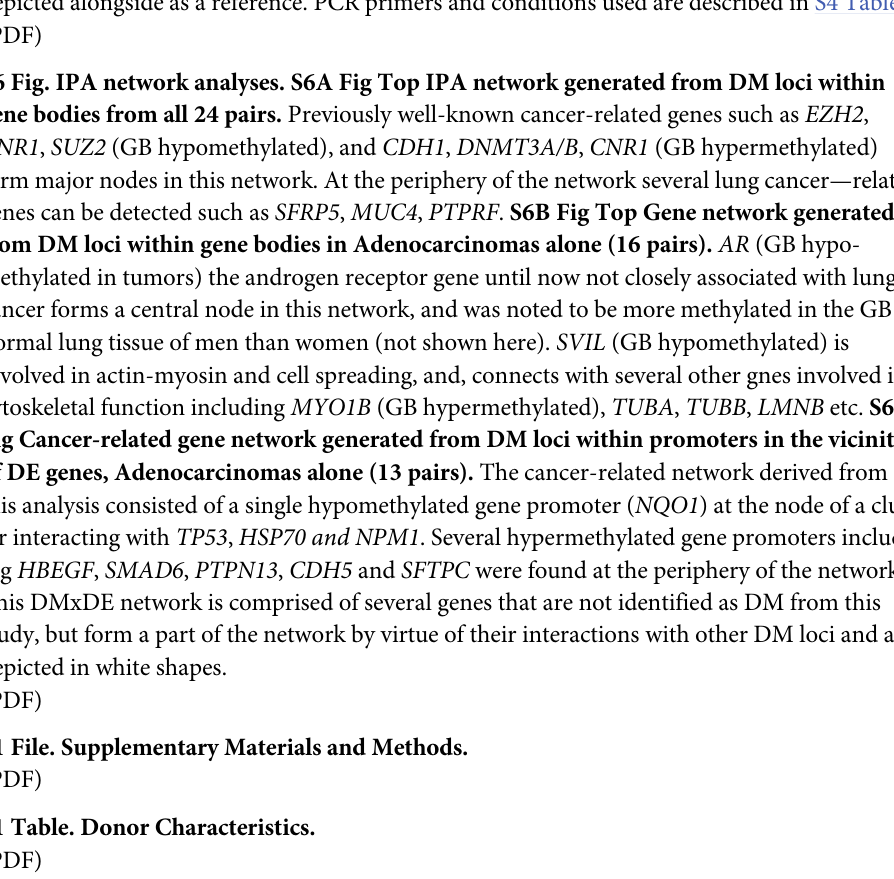
S5 Fig. Validation of gene-expression changes by qRT-PCR. Verification was performed in top representative genes that show canonical promoter patterns; PR:hypermethylation and GE downregulation and PR:hypomethylation & GE upregulation. Among DE genes associated with promoter DM loci (S3 Table), these eight genes were selected for qRT-PCR quantitation of gene-expression. All fold changes are depicted for T relative to matched NT; gene-expression values were normalized to GAPDH expression levels. Microarray fold-change values are depicted alongside as a reference. PCR primers and conditions used are described in S4 Table. S6 Fig. IPA network analyses. S6A Fig Top IPA network generated from DM loci within gene bodies from all 24 pairs. Previously well-known cancer-related genes such as EZH2 , CNR1 , SUZ2 (GB hypomethylated), and CDH1 , DNMT3A/B , CNR1 (GB hypermethylated) form major nodes in this network. At the periphery of the network several lung cancer — related genes can be detected such as SFRP5 , MUC4 , PTPRF . S6B Fig Top Gene network generated from DM loci within gene bodies in Adenocarcinomas alone (16 pairs). AR (GB hypo- methylated in tumors) the androgen receptor gene until now not closely associated with lung cancer forms a central node in this network, and was noted to be more methylated in the GB of normal lung tissue of men than women (not shown here). SVIL (GB hypomethylated) is involved in actin-myosin and cell spreading, and, connects with several other gnes involved in cytoskeletal function including MYO1B (GB hypermethylated), TUBA , TUBB , LMNB etc. S6C Fig Cancer-related gene network generated from DM loci within promoters in the vicinity of DE genes, Adenocarcinomas alone (13 pairs). The cancer-related network derived from this analysis consisted of a single hypomethylated gene promoter ( NQO1 ) at the node of a clus- ter interacting with TP53 , HSP70 and NPM1 . Several hypermethylated gene promoters includ- ing HBEGF , SMAD6 , PTPN13 , CDH5 and SFTPC were found at the periphery of the networks. This DMxDE network is comprised of several genes that are not identified as DM from this study, but form a part of the network by virtue of their interactions with other DM loci and are depicted in white